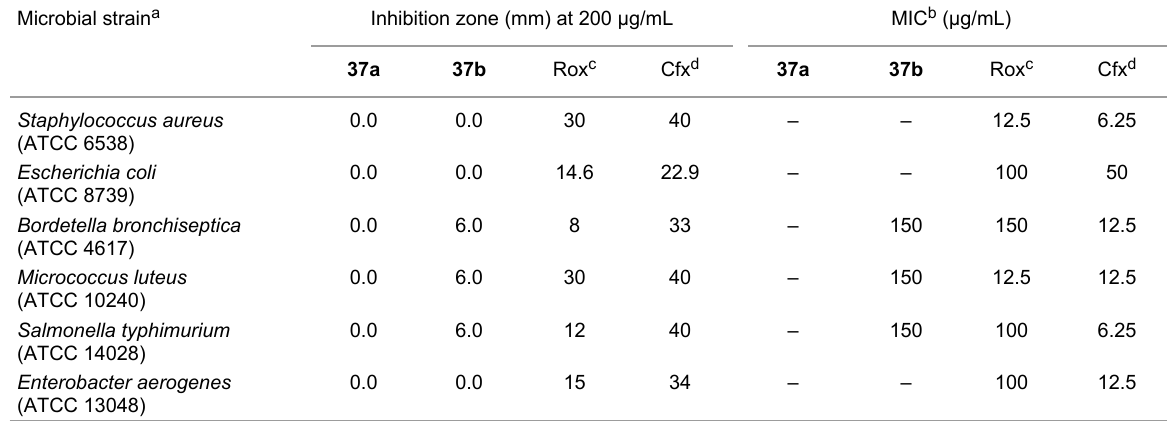
Table 2: Antibacterial activity in vitro